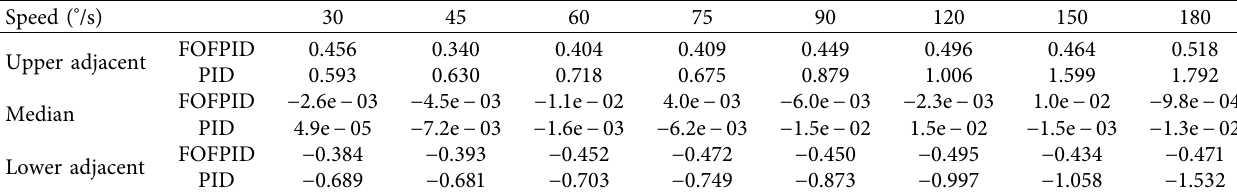
Table 2: Statistics of error upper boundary, lower boundary, and median under eight